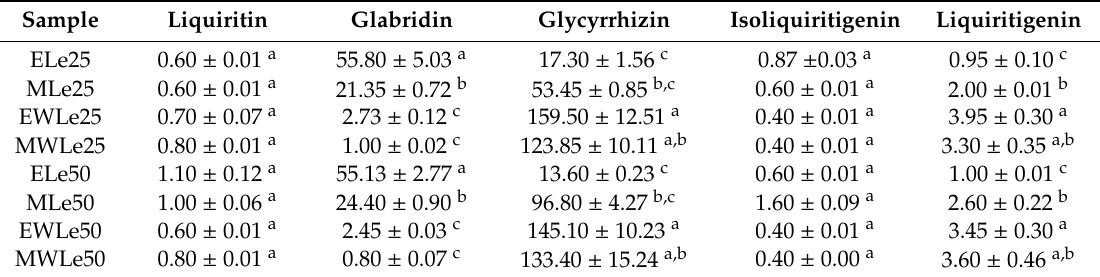
Table 2. Concentration (mg / g extract) of bioactive compounds identified in licorice UAE extracts (High Performance Liquid Chromatography—HPLC analysis).